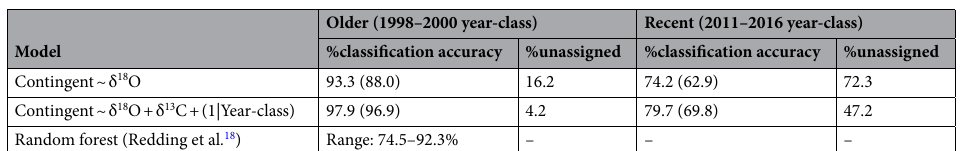
Table 1. Cross-validated mean classification accuracy and proportion of unassigned fish of the classification model that relied only on δ 18 O values and the mixed effects model which included δ 13 C values as a second predictor and accounted for year-class effects as a random intercept. Classification accuracy is shown for threshold classification probability level of > 0.7 (outside parenthesis) and > 0.5 (inside parenthesis). Classification accuracy of the year-class specific approach which used a Random Forest procedure that relied only on δ 18 O values is also shown 18